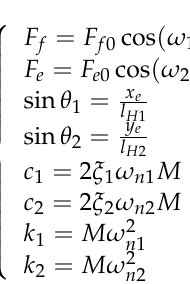
Figure 7. Equivalent model of blade testing system forced displacement biaxial testing device.